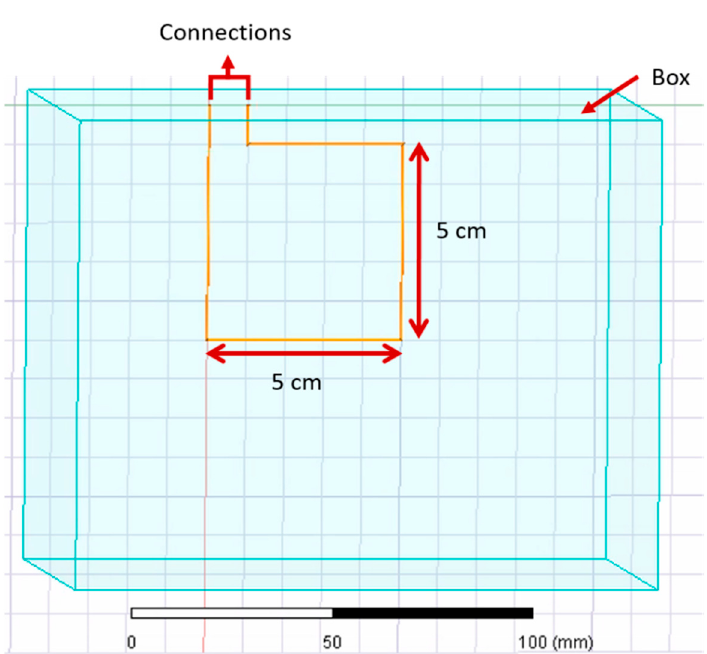
Figure 5. The sensor’s characteristics used to compare the simulated inductance value of different materials.